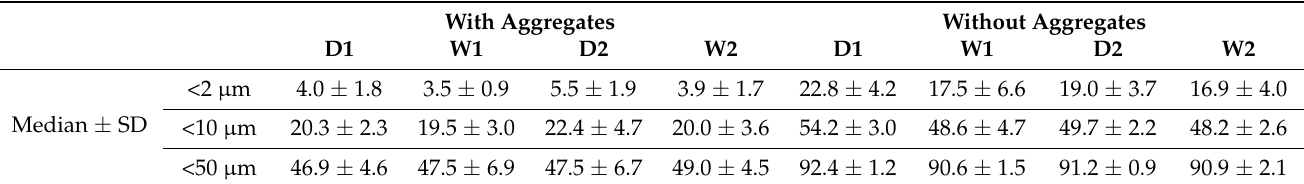
Table 4. Statistical analysis (median and standard deviation) of influence of initial conditions to the particle size distribution (obtained by LD) for the samples from the plot with slope 30 ◦ [%]. With Aggregates Without Aggregates D1